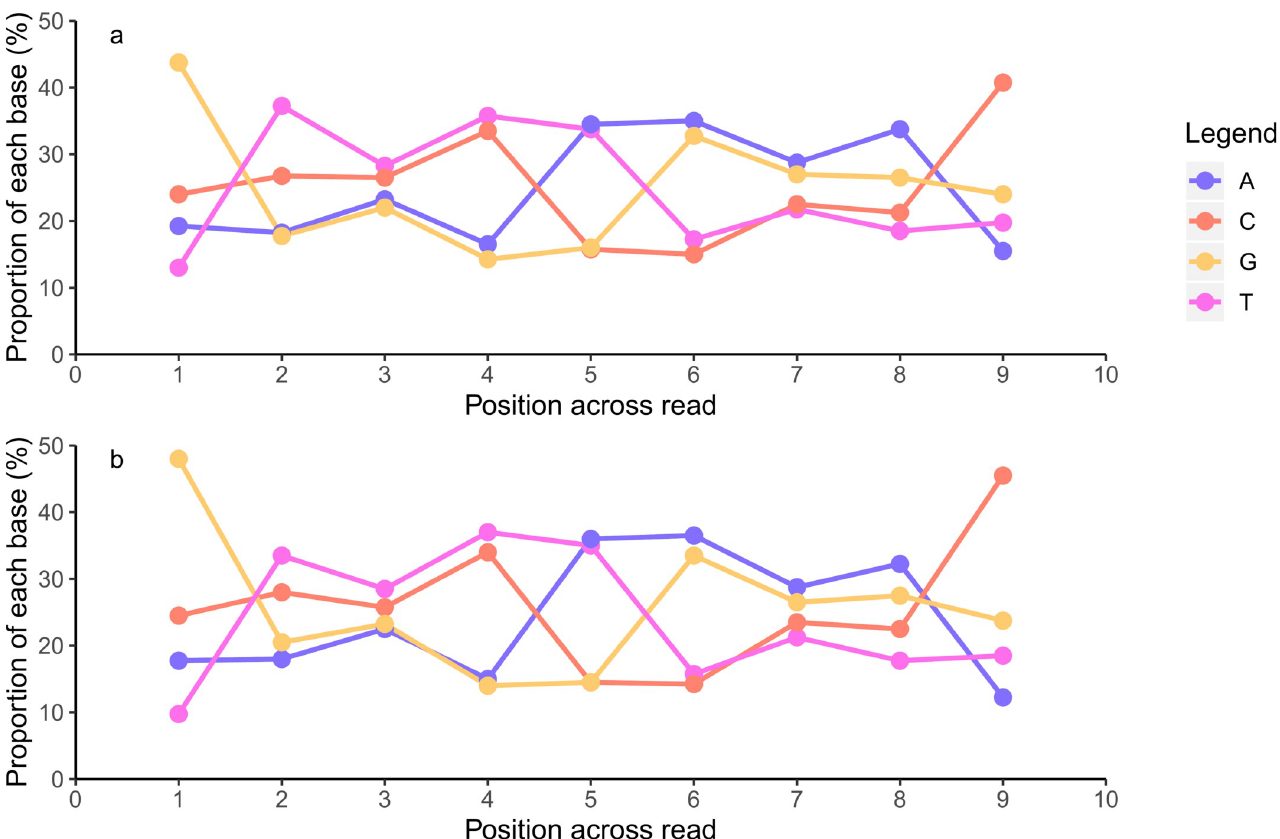
Fig 5. Tagmentation bias observed in both the Nextera XT and DNA Prep library preparation kits. (A, B) The average proportion of each of the four bases at the first nine positions of each read is displayed here (A: Nextera XT, B: DNA Prep), indicating that a highly similar sequence motif is preferentially tagmented by the transposome in both library preparation kits